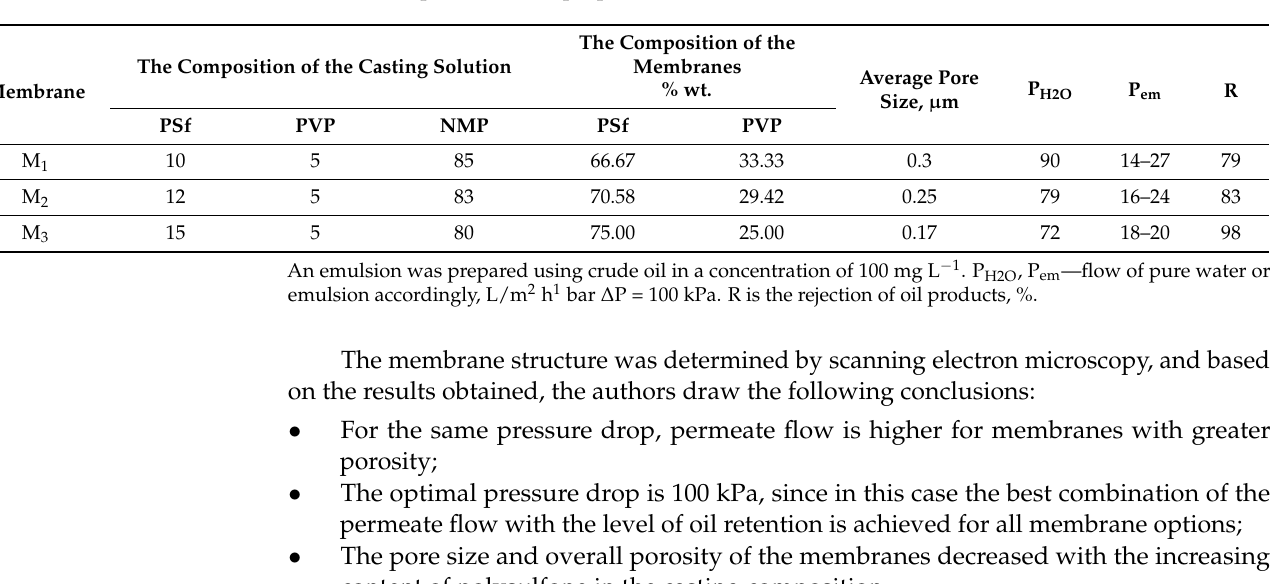
Table 1. Comparison of the properties of modified PSf membranes [44].